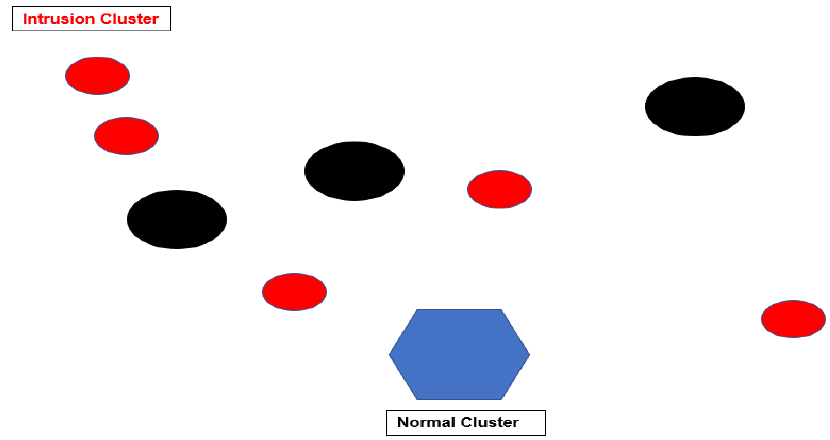
Figure 2. Cluster classification: intrusion and normal clusters.